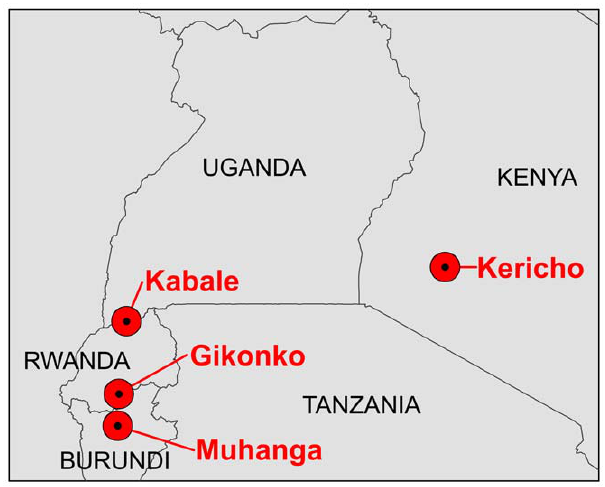
Figure 1. Location map. Sites at which monthly temperature data were analyzed are shown in red. Countries for which P. falciparum parasite rate data were analyzed are labeled. The map extent exactly matches the area defined by Patz et al . [19] across which CRU TS 2.1 and 3.0 data were tested: 4 u S, 4 u N, 28 u E, 38 u E.